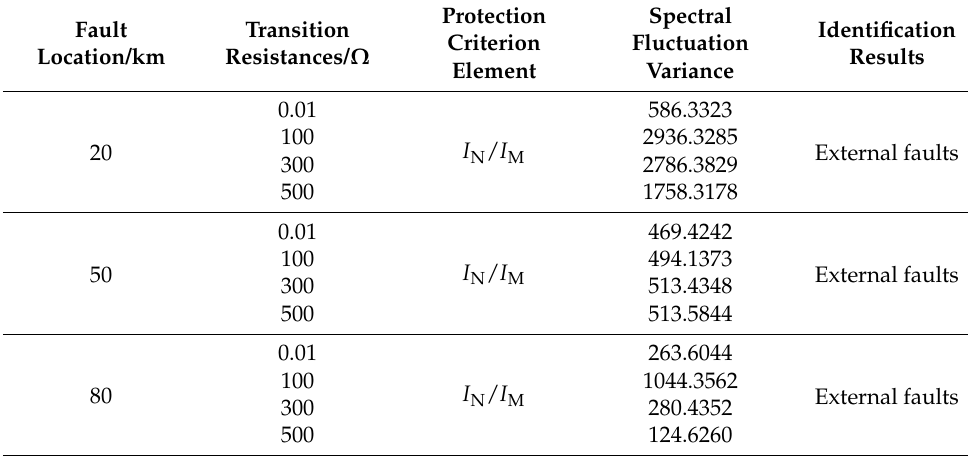
Table 6. Spectrum fluctuation variance in fault current ratio in the case of external A-phase ground faults with different transition